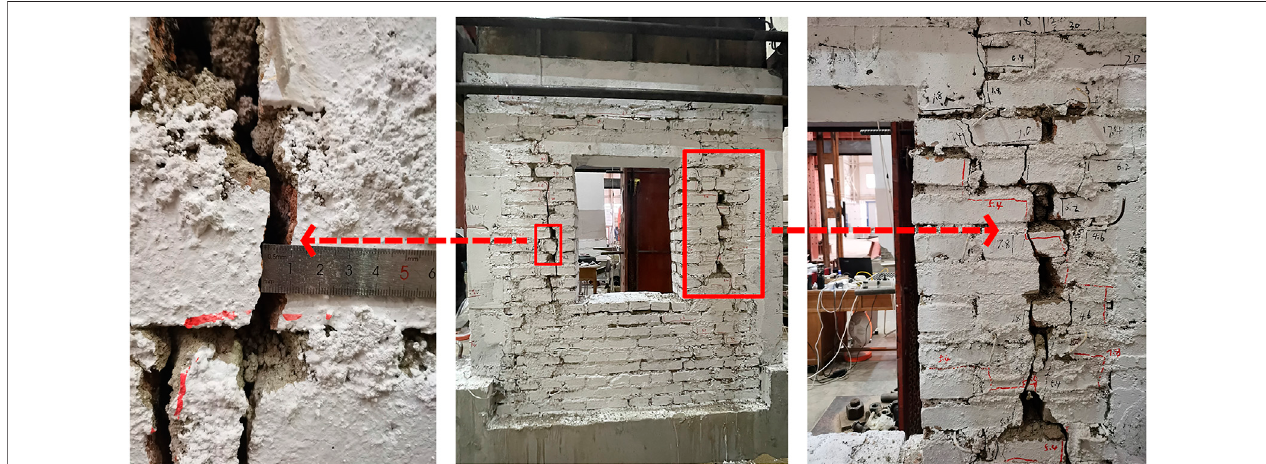
FIGURE 5 | Failure mode and crack pattern for URMW-1 at ultimate displacement.